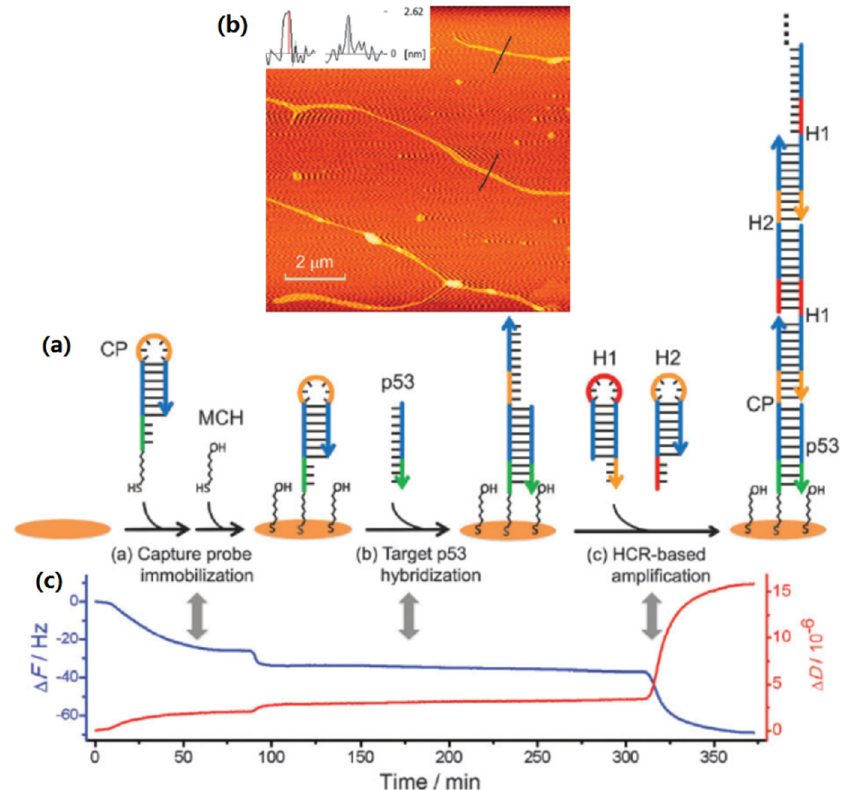
Figure 9. Self-assembled DNA nanostructure-based QCM biosensing of nucleic acids ( a ) Schematic presentation for the formation of DNA nanostructure for QCM biosensing; ( b ) Typical AFM image of the self-assembled DNA nanowires; ( c ) Corresponding QCM response curves related to the steps in ( a ) (Reprinted with permission from [189], published by Royal Society of Chemistry, 2012).